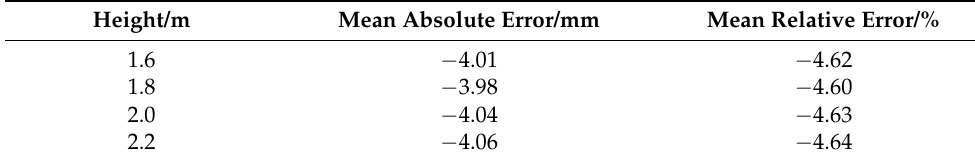
Table 6. Average Diameter Measurement Error at Various